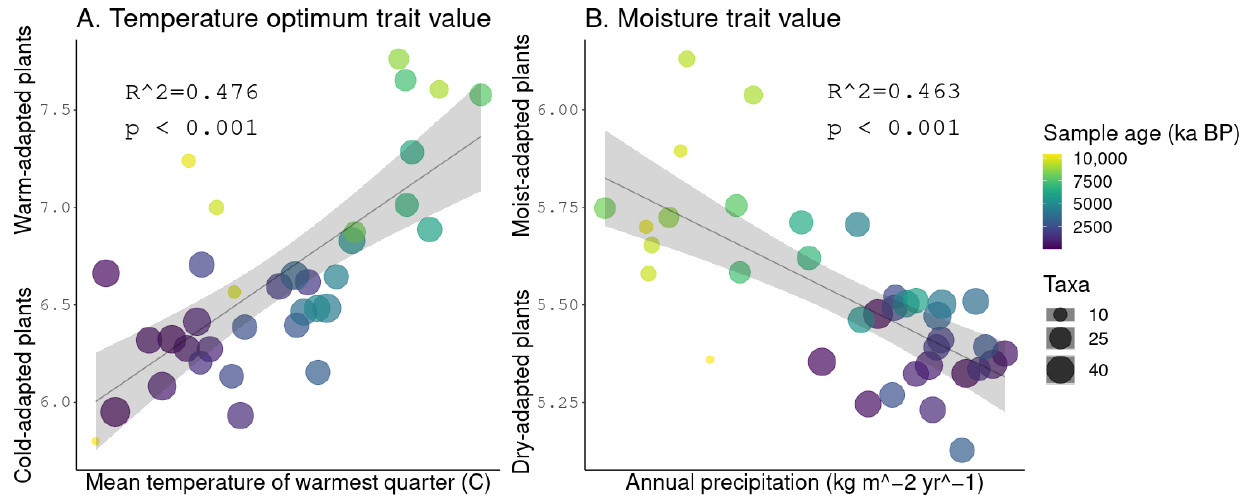
Figure 5. Linear regression of ( A ) the mean temperature of the warmest quarter and the temperature optimum trait value and ( B ) the annual precipitation and moisture trait value. The number of plant taxa used to calculate the weighted average is shown as point size while sample age is represented as a color scale. Note that temperature optimum index values are inverted from those reported in [21].